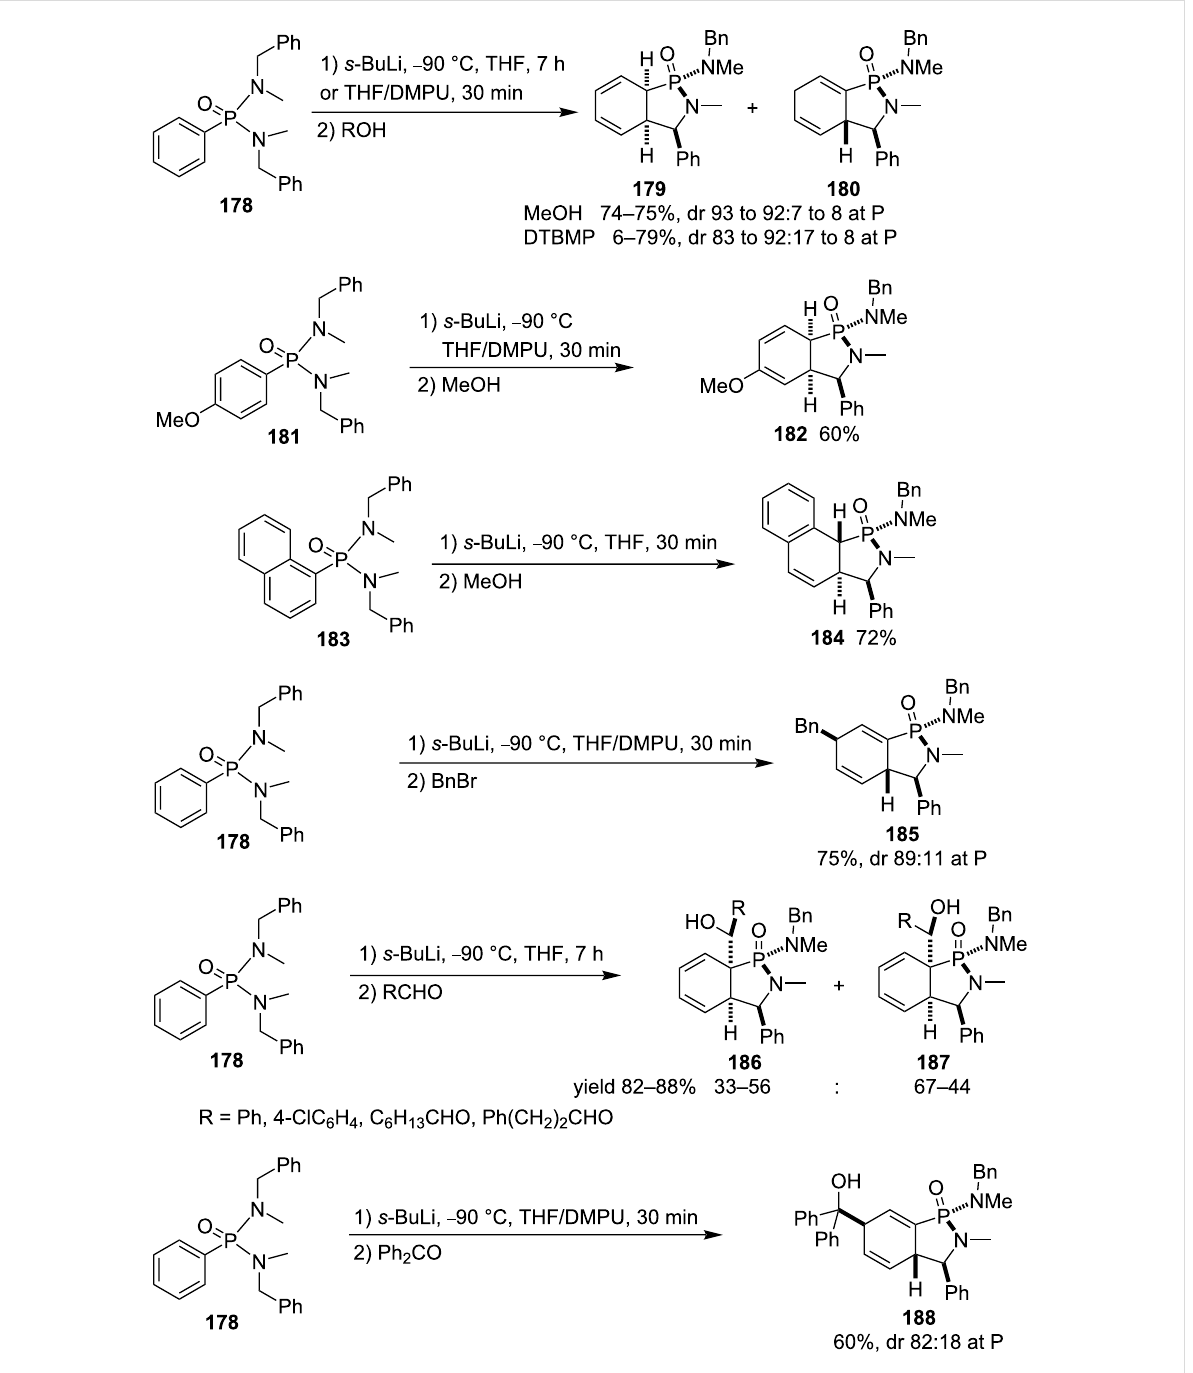
Scheme 28: Synthesis of cyclohexadiene-fused 1-( N -benzyl- N -methyl)amino- γ -phosphinolactams from aryl- N,N’ -dibenzyl- N,N ’-dimethylphosphonodi- amides.